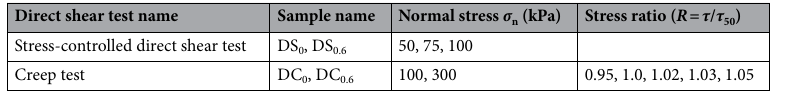
Table 2. Direct shear and creep testing programmes. τ , shear stress; τ 50 , shear stress associated with δ h = 50